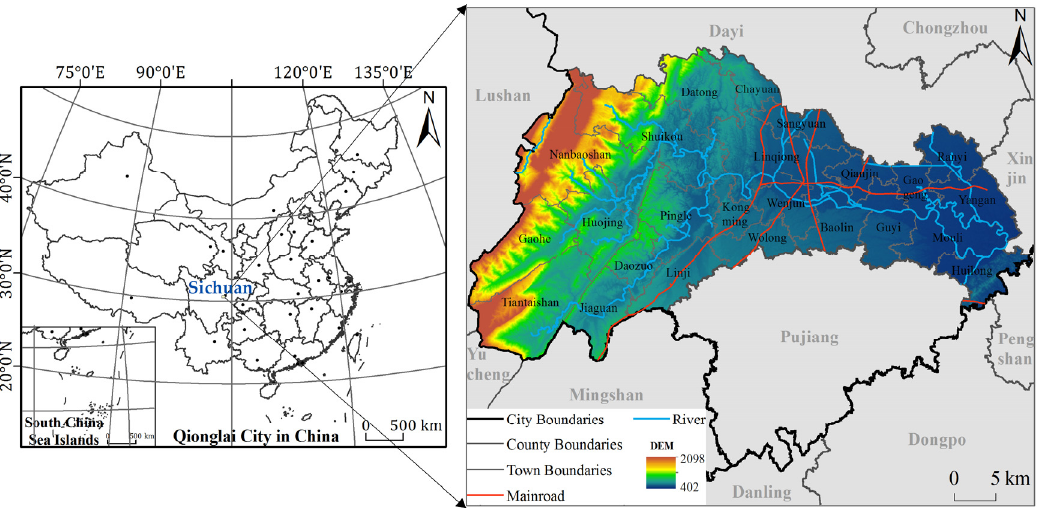
Figure 1. Geographical location of the study area.